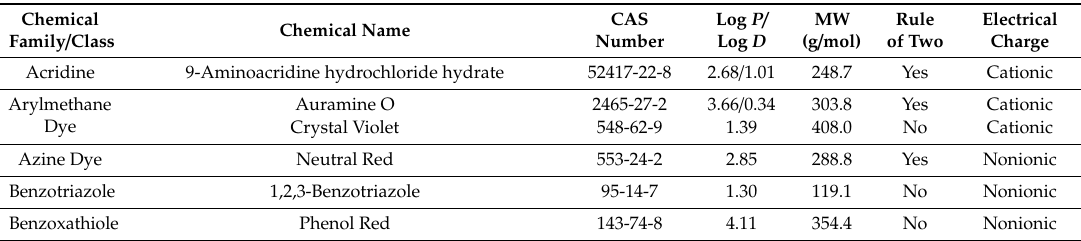
Table 1. List of 32 fluorescent and / or colored tracers grouped by chemical family / class, chemical name, Chemical Abstracts Service Registry Number (CAS number), log P or log D at pH 6.5, molecular weight (MW), compliance with the rule of two, and electrical charge at pH 6.5. Values obtained from the Chemicalize database [17], in compliance with the rule of two with the following parameters or